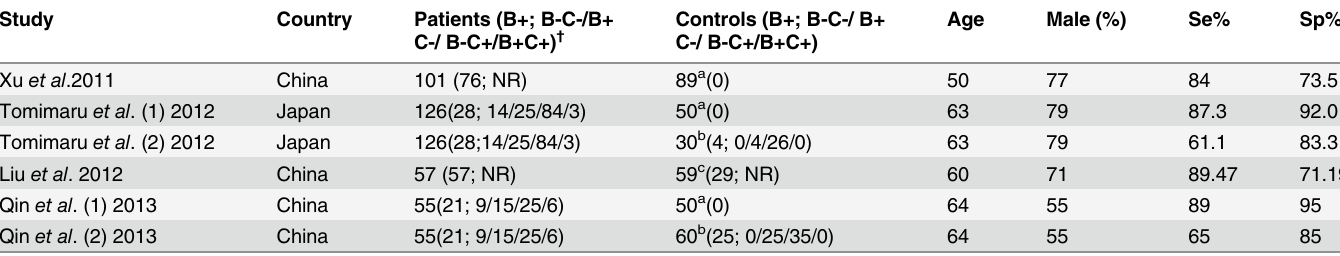
Table 1. Main characteristics of the studies included in the